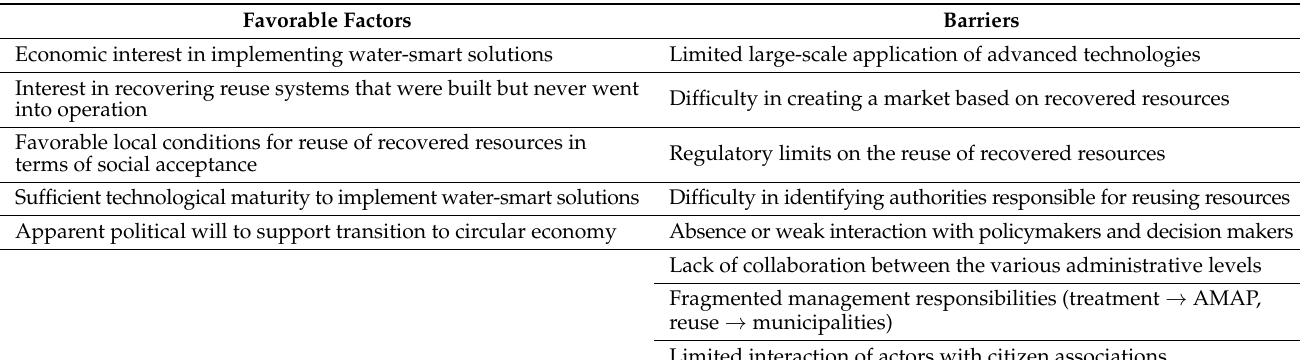
Table 4. Summary table of favorable factors and